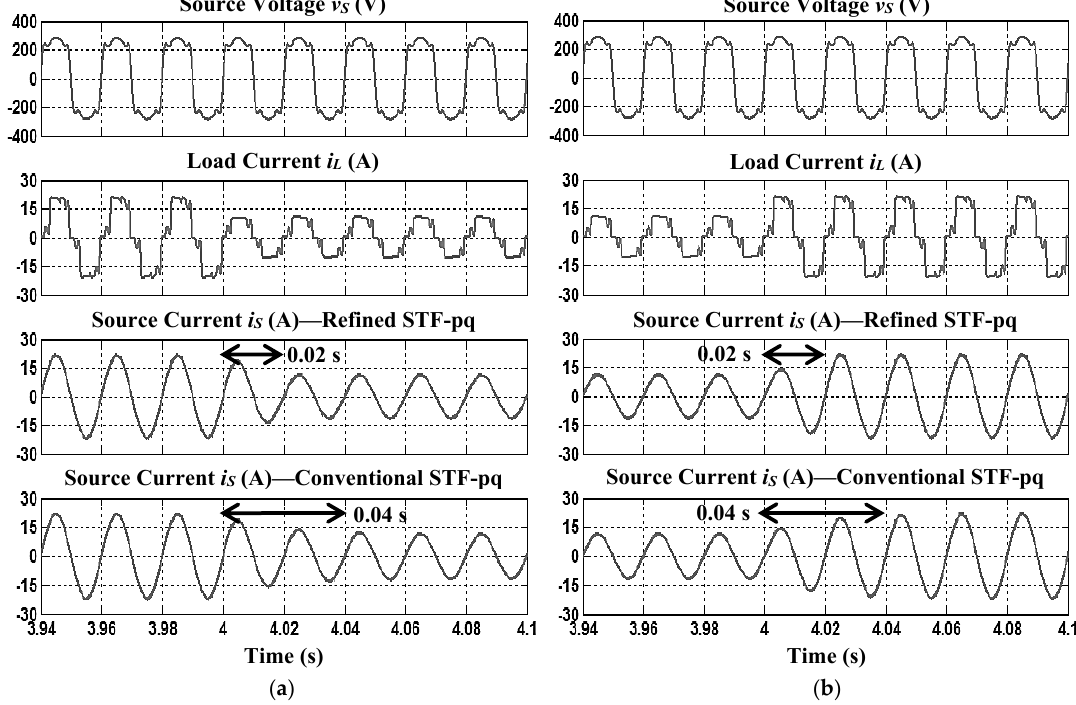
Figure 5. Phase A simulation waveforms (case 1) which include source voltage v S , load current i L , source current i S resulted from refined STF-pq theory algorithm, and source current i S resulted from conventional STF-pq theory algorithm for dynamic-state conditions of ( a ) resistive to inductive and ( b ) inductive to resistive.